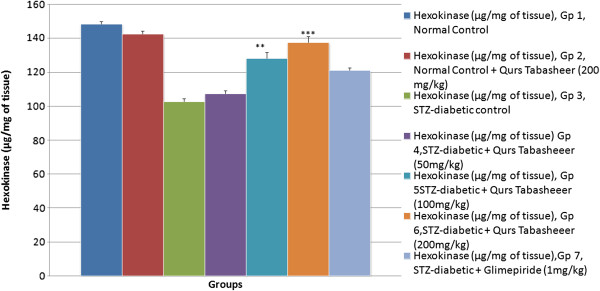
Effect of Qurs Tabasheer on level of hexokinase at different concentrations on normal and STZ induced diabetic rats, compared to standard drug Glimepiride; values are mean ± SEM; n = 6; *P < 0.05; **P < 0.01; ***P < 0.001; P > 0.05 is considered as non-significant (ns).